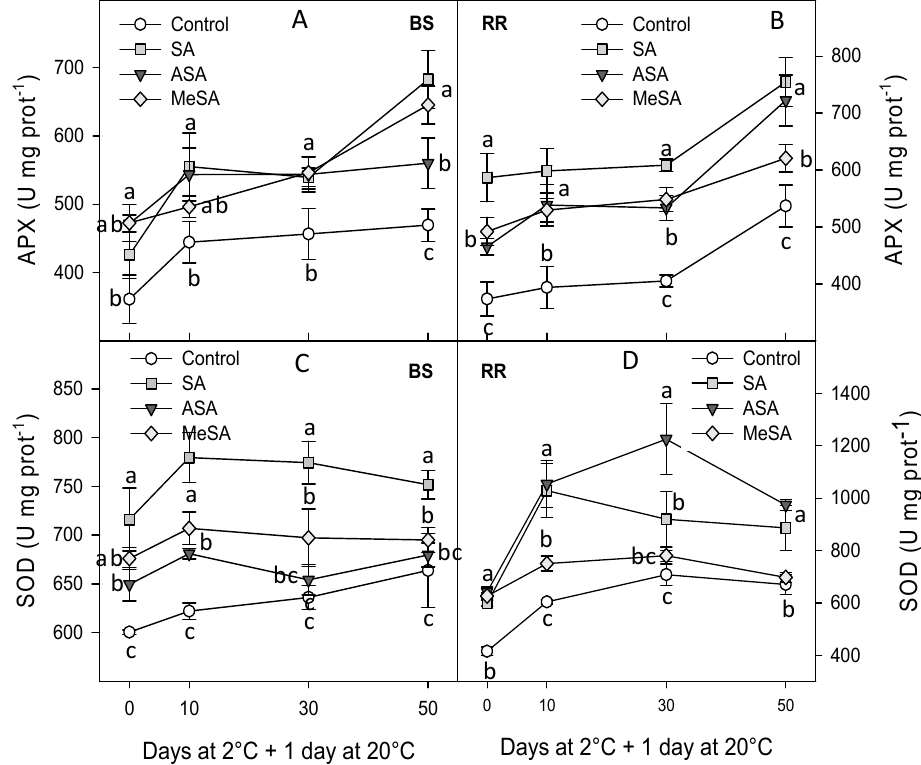
Figure 5. Activity of ascorbate peroxidase (APX) for “Black Splendor” (BS) ( A ) and “Royal Rosa” ( B ) cultivars and superoxide dismutase (SOD) for “Black Splendor” (BS) ( C ) and “Royal Rosa” ( D ) plum cultivars from control and salicylic acid (SA)-, acetyl salicylic acid (ASA)-, and methyl salicylic acid (MeSA)-treated trees at harvest and along storage at 2 ° C + 1 day at 20 ° C. Data are the mean ± SE of three replicates. Different lowercase letters show significant differences ( p < 0.05) among treatments for each sampling date and cultivar.